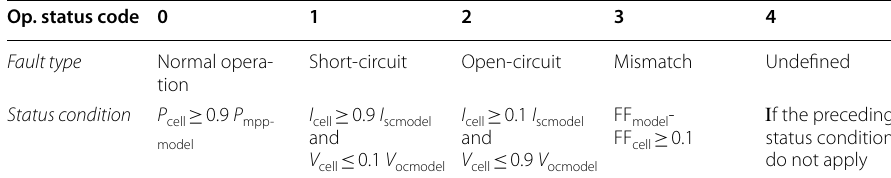
Table 2 Operational status code encodings–conditions Op. status code 0